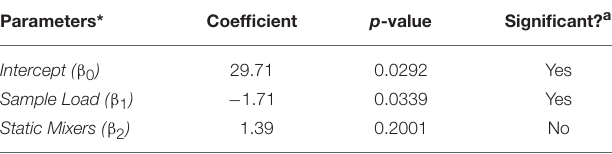
TABLE 5 | Linear regression results.